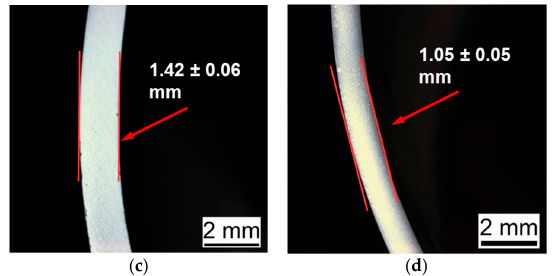
Figure 4. Images of ( a , c ) for a green-state CS T10 sample with its cross-section image and ( b ); and ( d ) a sintered CS T10 sample with its cross-section image. The radii results measured on a CS T10 ceramic sphere’s surface are presented in Figure 5, in which the measured points are indicated as circular dotted lines in blue. The ceramic sphere has an average radius of 26.00 mm with a standard deviation of 0.10 mm: